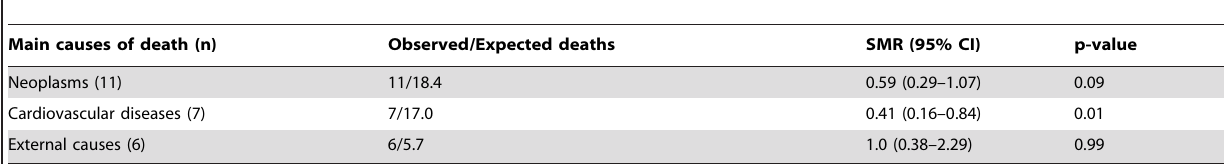
Table 2. French Olympic rowers’ main disease-specific mortality compared with the French general population.